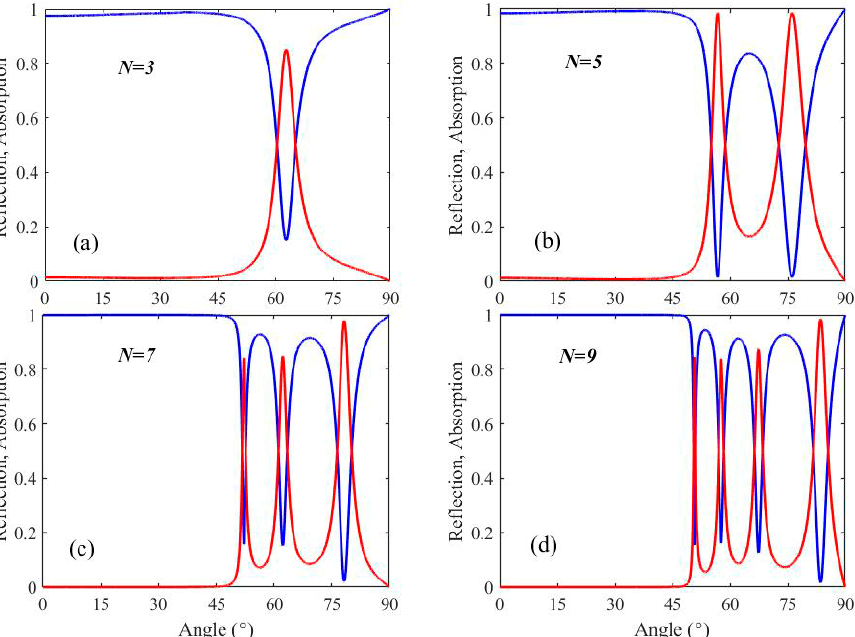
Figure 3. Absorption and reflection spectra of the DBR conjugated with the Bi 2 Se 3 layer at a different period number of TiO 2 /SiO 2 Bragg mirror under TE polarization. ( a ) N = 3, ( b ) N = 5, ( c ) N = 7 and ( d ) N = 9. The Bi 2 Se 3 layer thickness is d 0 = 25 nm, and the other parameters are set as d 1 = 96 nm, d 2 = 172 nm and t = 80 nm. The SF10 prism is used as the matrix (with refractive index n p = 1.7).